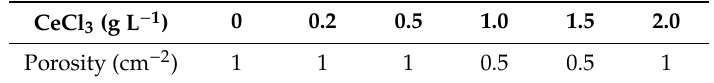
Table 4. Porosity of the Pd-Ni alloy films that were obtained in the solutions with different contents of CeCl 3.